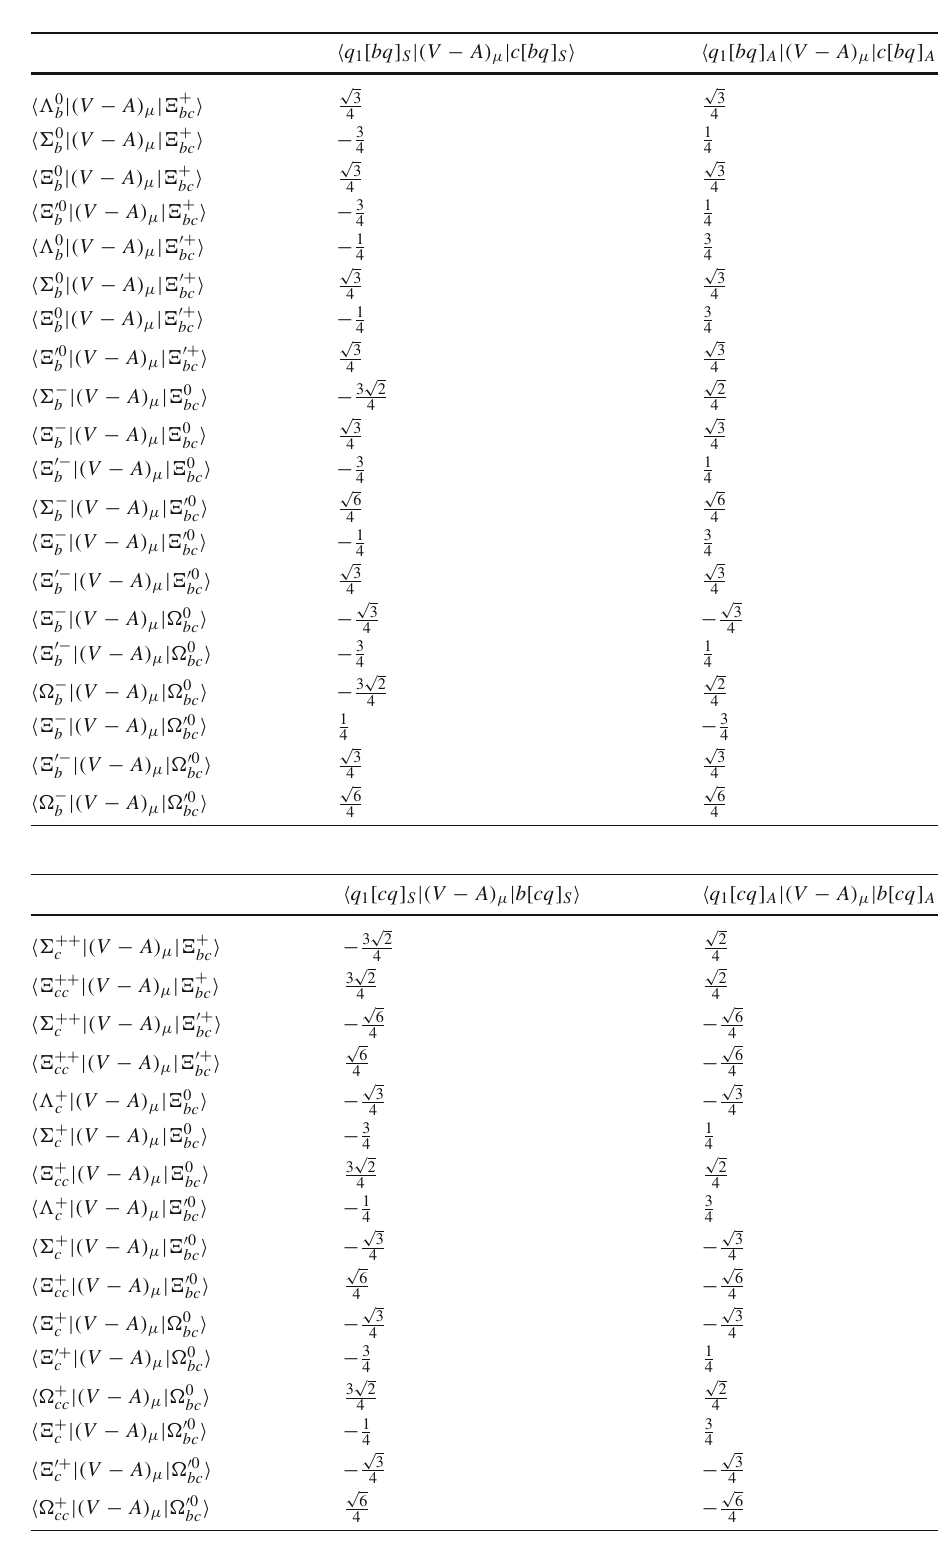
Table 5 Same as Table 3 but for the bottom–charm baryons with charm decays